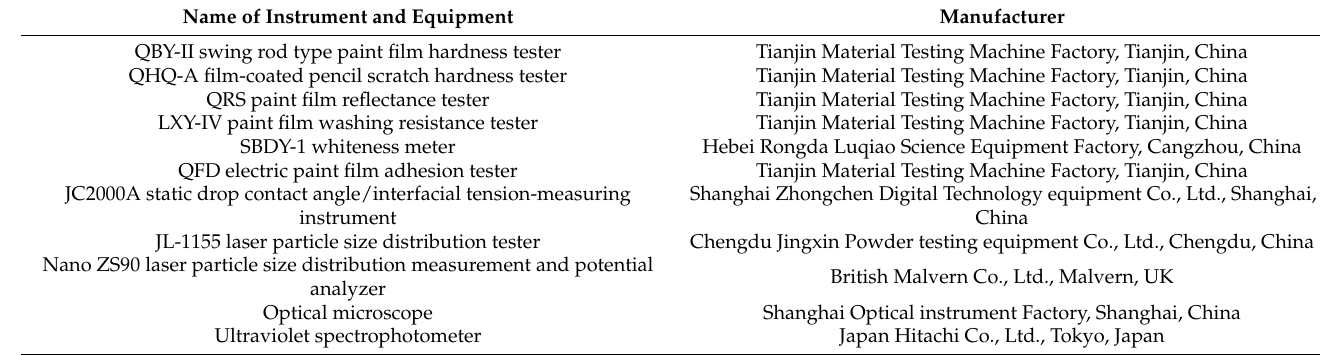
Table 7. Main test equipment and analytical